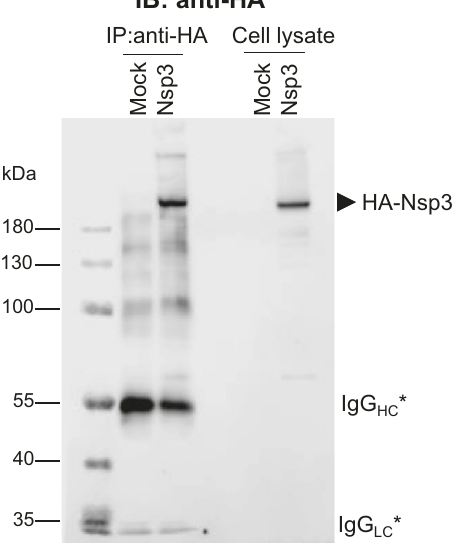
CHOP2 assay in the presence of the dose range of B compound 7 or C GRL0617. Data are presented as mean values for n =2 independent experiments for com- pound 7 and n =3 independent samples for GRL0617. Curves are nonlinear regressionstothenormalizeddoseresponseequation.Sourcedataareprovidedas a Source Data fi